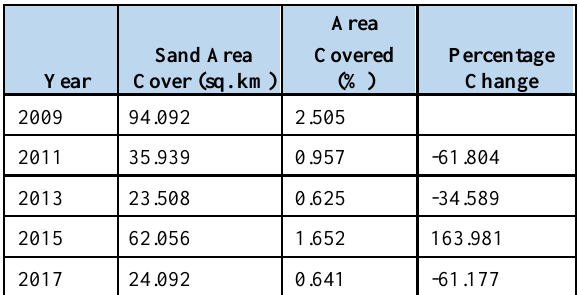
Table 1: Sand Area Change in Mohana-Macheli Watershed from 2009 to 2017